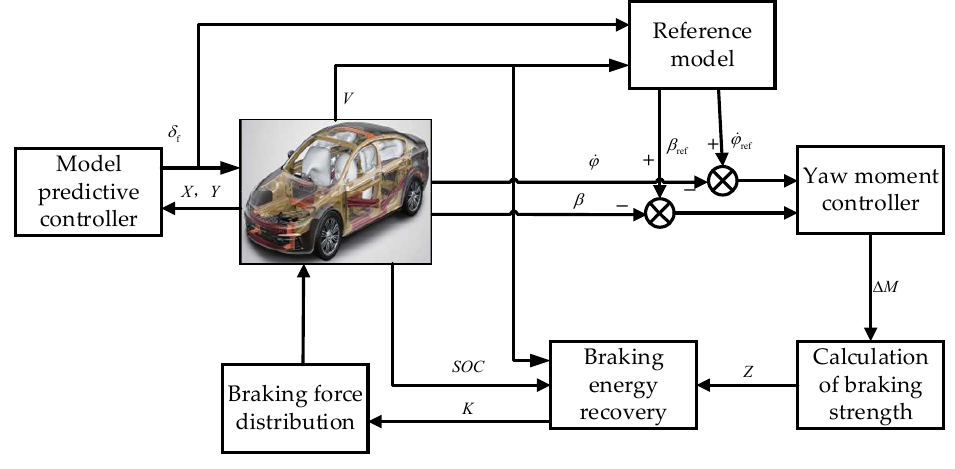
Figure 1. Control system architecture. Figure 1 is the control system structure,